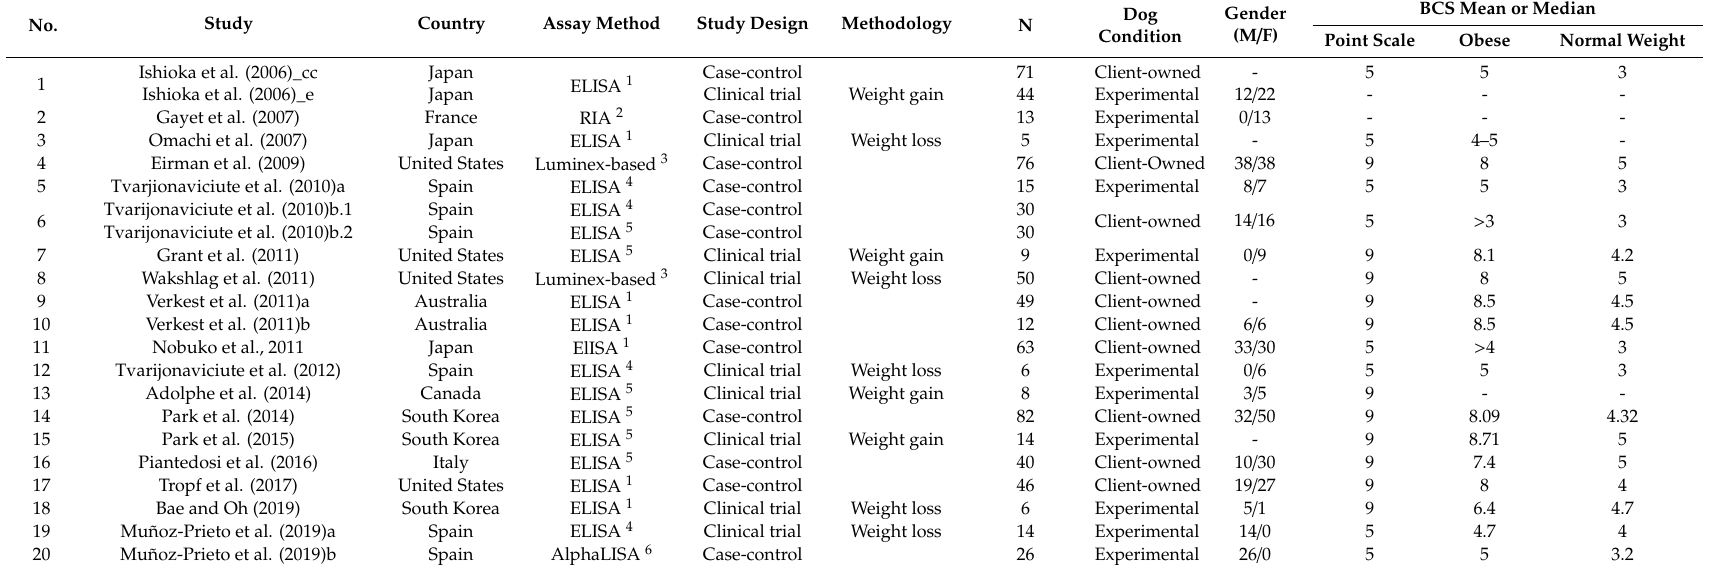
Table 1. Study characteristics of studies determining serum or plasma total adiponectin concentrations included in the meta-analysis.